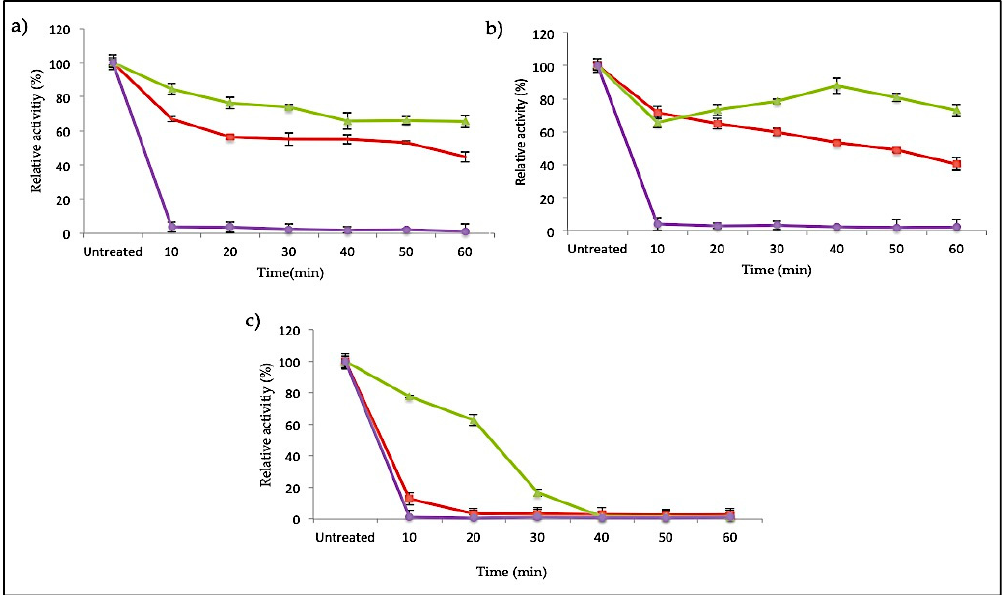
Figure 7. Thermal stability profile of SK72 DNA polymerase and its variants. ( a ) 50 °C, ( b ) 60 °C, and ( c ) 70 °C. Purified enzymes were pre-incubated for 30 min at different temperatures prior to polymerase assay at the optimum temperature of each variant. Untreated enzymes were measured relative to the activity of the enzymes without pre-incubation. Symbols represent the enzyme variants; SK72 (filled triangle), SK72-Exo (filled square), and SK72-Exo2 (filled circle). Error bars represent standard deviation ( n = 3). The absence of the bar indicates that the error is smaller than the symbols.